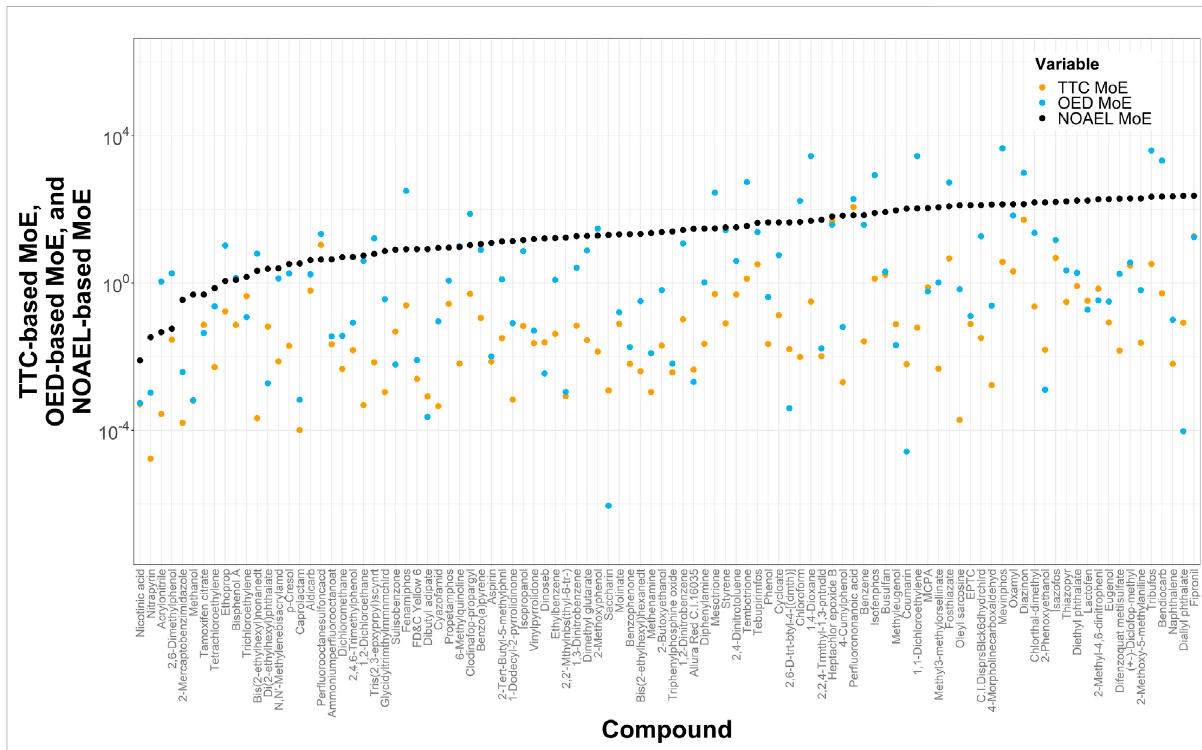
FIGURE 4 Plot of margins of exposure estimated by dividing TTCs, OEDs, and NOAELs, by ExpoCast SEEM exposures yielding TTC-, OED-, and NOAEL- based MoEs, respectively. This plot shows the lowest 100 NOAEL-based MoEs (from the dataset of 522) and shows those MoEs in increasing order fromlefttoright.Forthisanalysis,the fi lterforGenotoxicitywasnotappliedfordeterminingtheTTCvalue,becausetheOEDsandNOAELsrepresent non-cancer